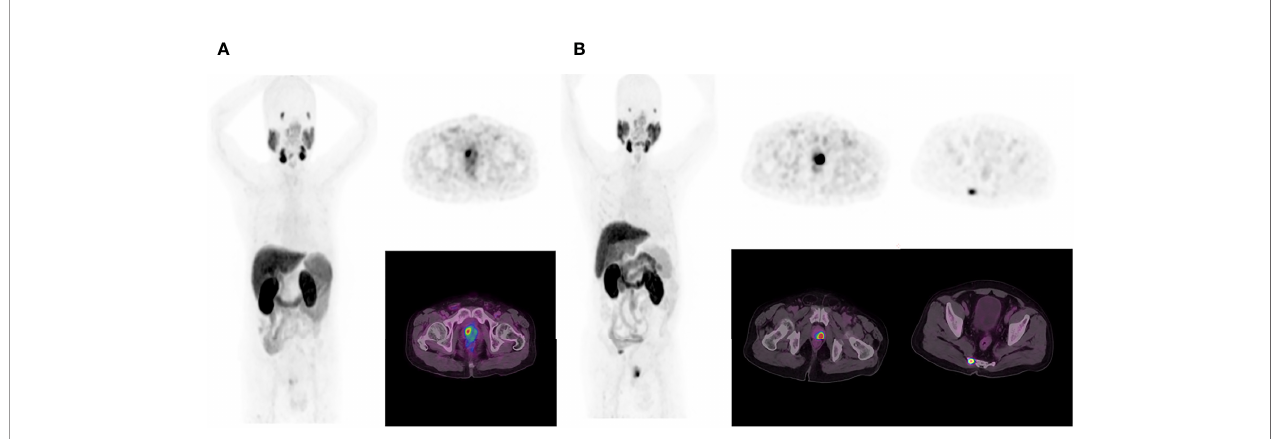
FIGURE 2 | In the fi rst patient (A) , 18 F-PSMA-1007 PET/CT results show primary prostate cancer on whole-body maximum intensity projection (MIP) image (left). Axial PET image (right up) and axial fused image (right bottom) show primary tumor in the right prostate cancer lobe. In the second patient (B) , 18 F-PSMA-1007 PET/ CT results show primary prostate cancer and tailbone metastasis on MIP image